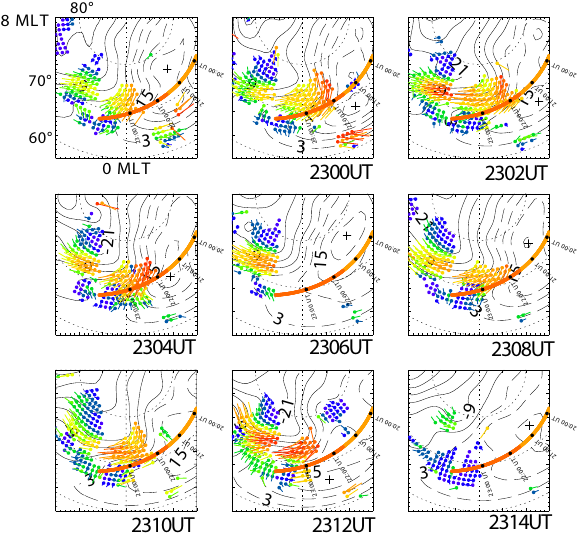
Fig. 10. SuperDARN map potential plots at two-minute intervals with the true vectors superposed from 22:58 until 23:14 UT on 1 CLUSTER 1 (Rumba) September 2002 and with Cluster 1 footprint also superposed.